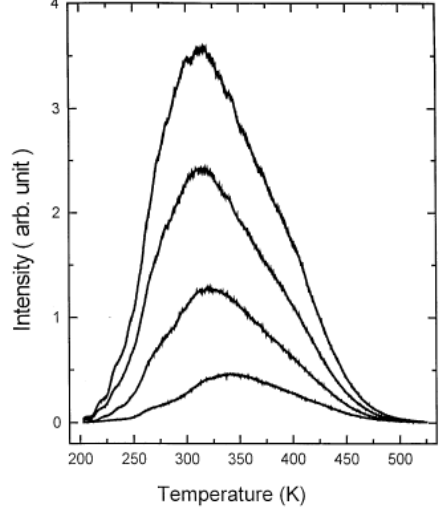
Figure 6. The glow curve for SrAl time. From bottom to top: 10, 30, 60 and 120 seconds (Reprinted with permission from